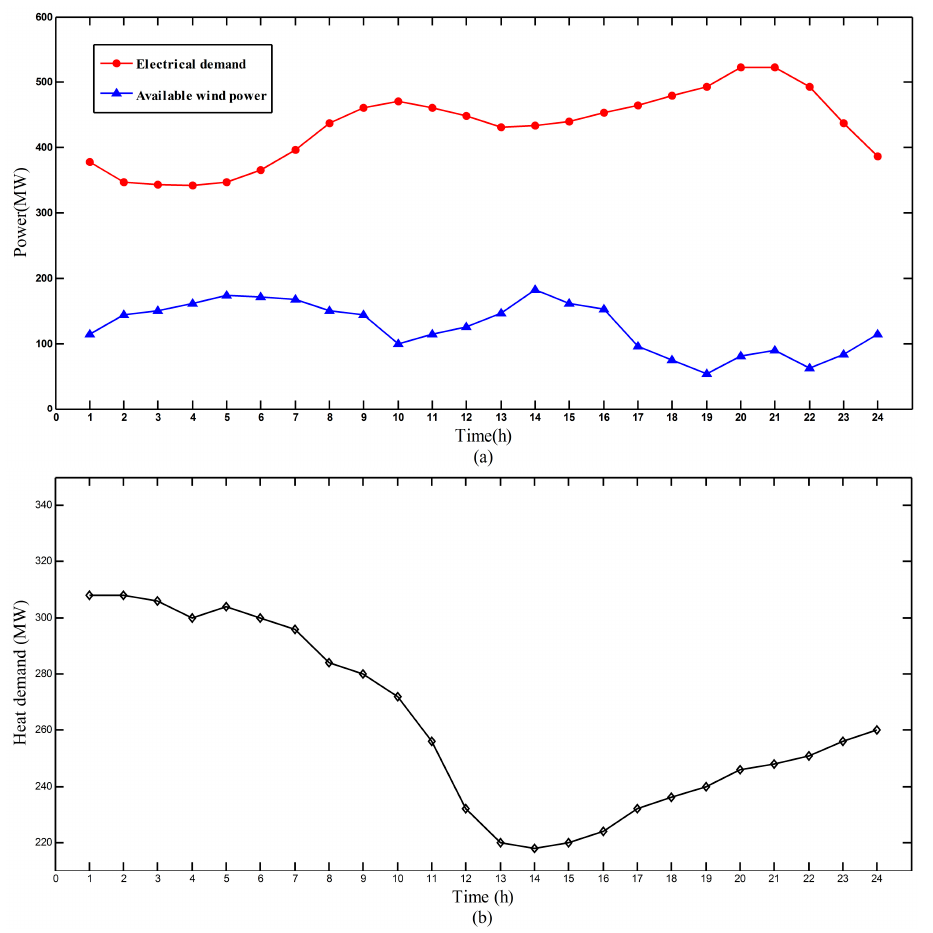
Figure 6. Profiles of ( a ) electrical demand, forecasted wind power output and ( b ) heat demand.